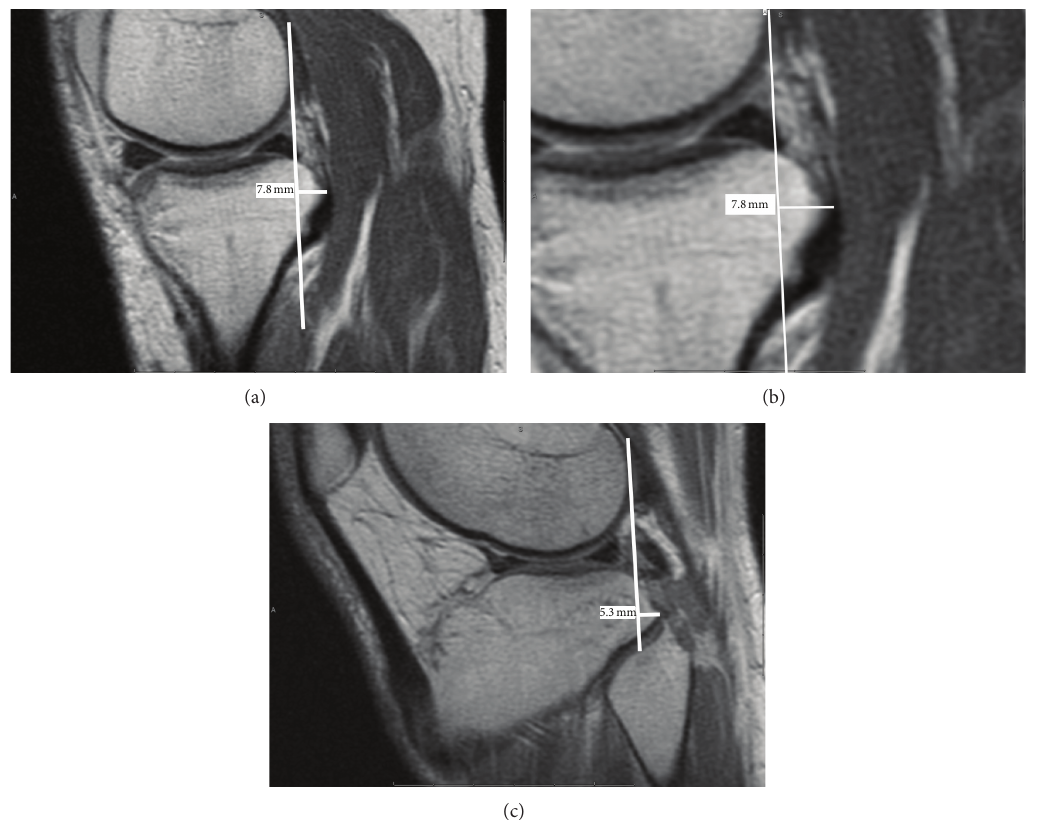
Figure 1: Measurement technique for tibial translation on knee MRI. Magnetic resonance images of the knee in a patient with isolated PCL tear were obtained using sagittal proton density weighted pulse sequence (TR = 3000; TE = 12.168; 1 NEX; 256 × 192 matrix; ETL = 8; 3.00 mm slice thickness). (a) Midmedial compartment measurement of tibial translation demonstrates posterior (+) tibial translation of 7.8mm in the presence of a PCL tear. (b) Magnified view of measurement of midmedial compartment. (c) Midlateral compartment measurement of tibial translation demonstrates posterior (+) translation of 5.3